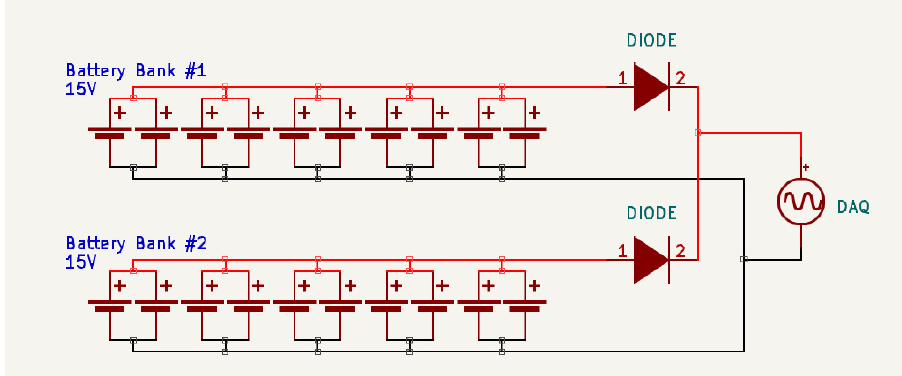
Figure 3. 15 V Nortek Battery Bank configuration for the Data Acquisition system.